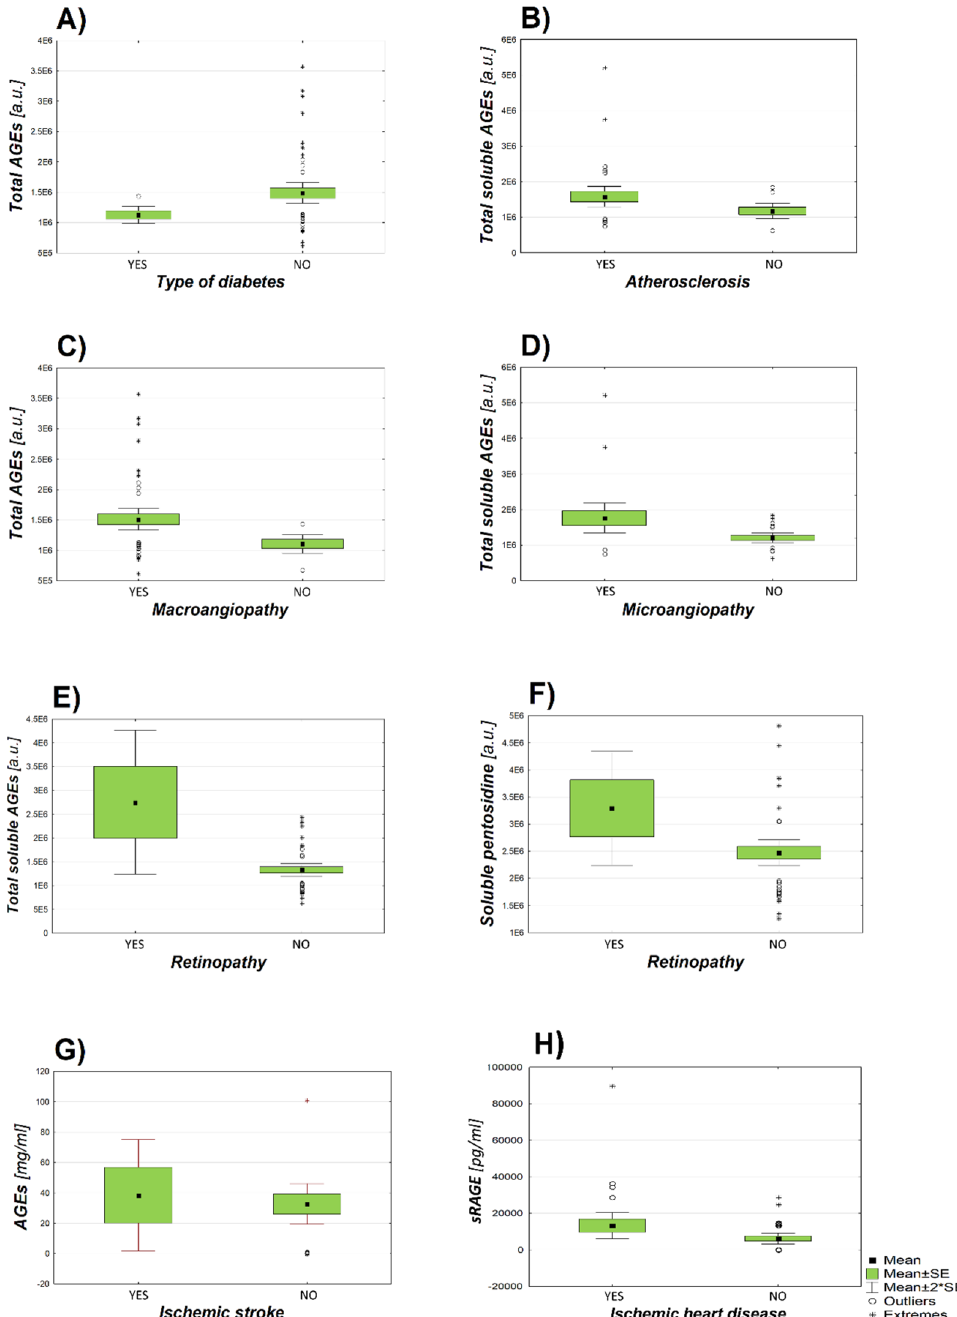
Figure 3. Graphs of the dependence of AGEs fluorescence or content of sRAGE in the samples and occurrence diabetic complications in patients. The numbers given are the mean value of the results and the standard error of the mean (Mean ± SE). ( A ) The dependence of total AGEs fluorescence on the type of diabetes; (number of subjects = 49; Type 1 (1,167,393 ± 70,632 a.u.), Type 2 (1,517,352 ± 98,785 a.u.)). ( B ) The dependence of total soluble AGEs fluorescence on the occurrence of atherosclerosis; (n = 47; YES (1,581,783 ± 145,154 a.u.), NO (1,179,192 ± 107,389 a.u.)). ( C ) The dependence of total AGEs fluorescence on the occurrence of macroangiopathy; (n = 58; YES (1,511,867 ± 619,228 a.u.), NO (1,105,011 ± 228,314 a.u.)). ( D ) The dependence of total soluble AGEs fluorescence on the occurrence of microangiopathy; (n = 47; YES (1,764,035 ± 207,484 a.u.), NO (1,205,829 ± 68,639 a.u.)). ( E ) The dependence of total soluble AGEs fluorescence on the occurrence of retinopathy; (n = 47; YES (2,749,771 ± 757,703 a.u.), NO (1,327,710 ± 66,108 a.u.)). ( F ) The dependence of soluble pentosidine fluorescence on the occurrence of retinopathy; (n = 47; YES (3,320,508 ± 527,192 a.u.), NO (3,069,839 ± 117,568 a.u.)). ( G ) The dependence of AGEs concentration determined in the competition ELISA test on the occurrence of ischemic stroke; (n = 39; YES (0.9252 ± 0.0687 mg/ml), NO (0.5244 ± 0.0517 mg/ml)). ( H ) The dependence of the concentration of sRAGE receptors on the occurrence of ischemic heart disease; (n = 49; YES (15,467 ± 3967 pg/ml), NO (7404 ± 1628